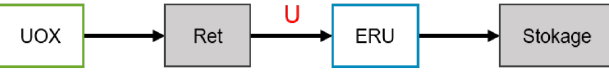
Fig. 6. Fuel cycle of a UOX - ERU fleet. Table 5. COSI6/SEPAR comparison of reprocessed